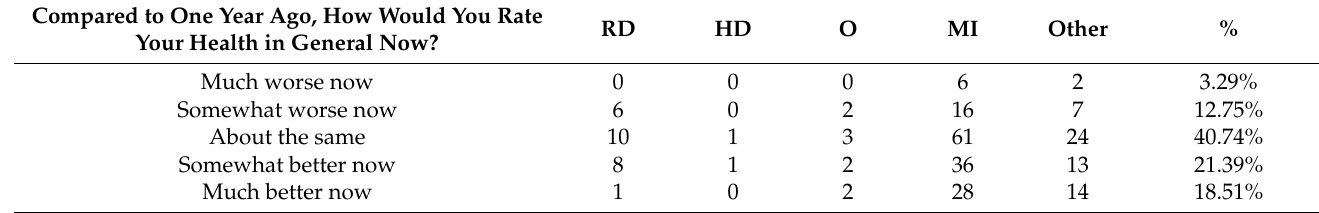
Table 9. Item number 2 of the QoL